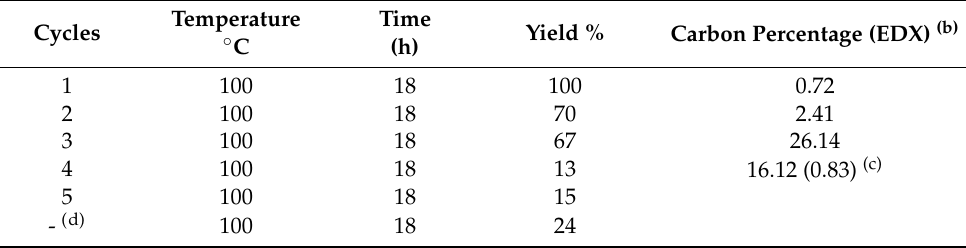
Table 4. Recycle of catalyst 1 (a) . Cycles